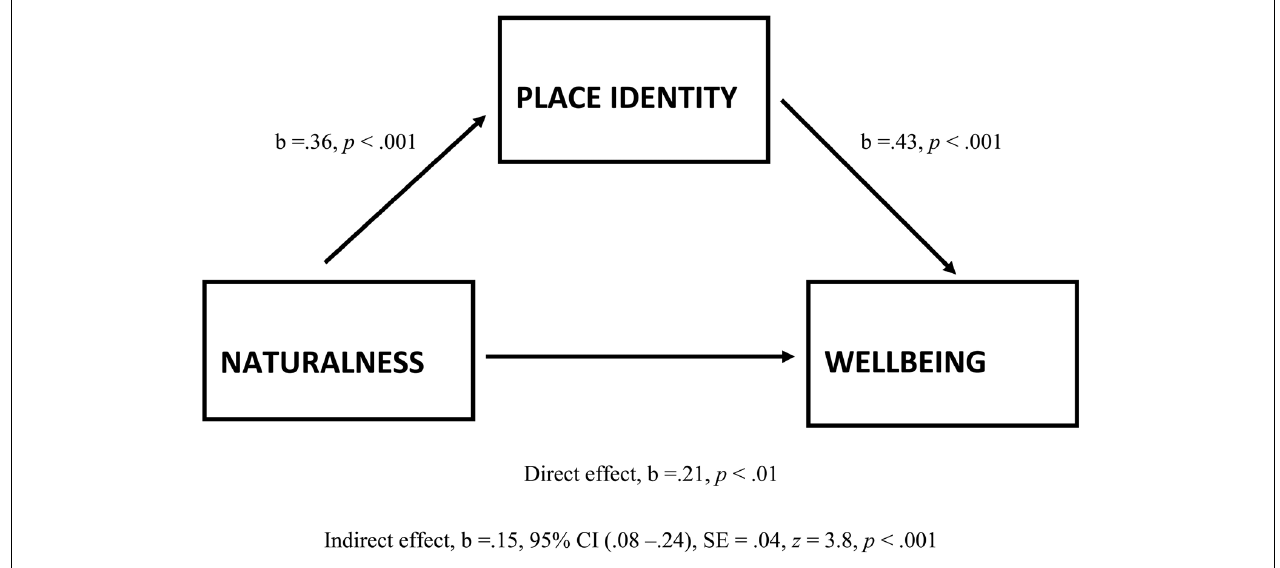
FIGURE 3 | Mediation model of naturalness as a predictor of wellbeing, mediated by place identity, including the mediation analysis statistics for relationships of: (1) naturalness → place identity; (2) place identity → wellbeing; (3) naturalness → wellbeing (direct effect); and (4) naturalness → wellbeing via place identity (indirect effect = mediation). ( b is an unstandardized regression coefficient, and CI is confidence interval for the bootstrap methods, between BootLLCI and